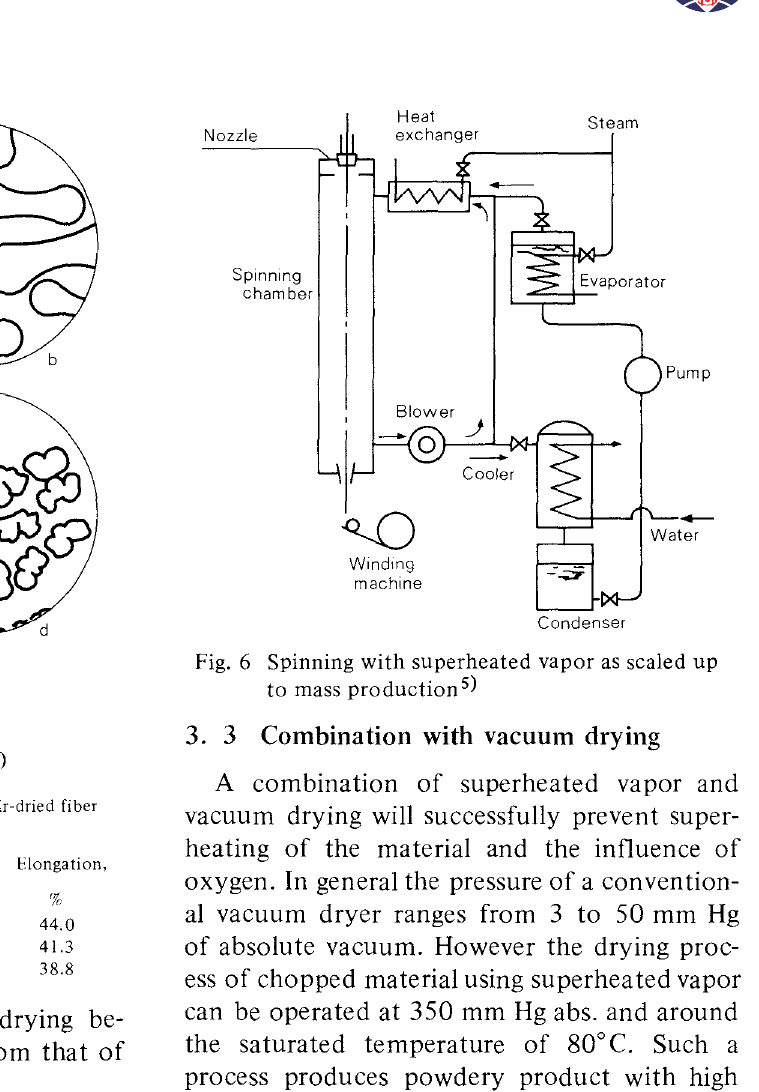
a, b, c. Fiber dried with superheated vapor.